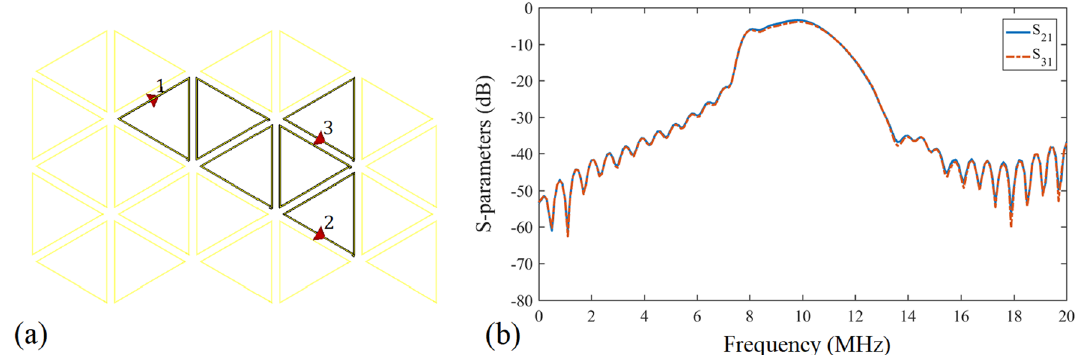
Figure 8. ( a ) A two-receiver power transfer plane model. The highlighted triangles are activated units, and inactive units are in light yellow. ( b ) S 21 and S 31 of the power transfer route in electromagnetic frequency of inactive units f i is 8 MHz in Fig. 7b, shifted by 1.9 MHz compared to activated state. As shown in Fig. 7a, the optimum result of S 21 after coupling through 5 activated units at 9.9 MHz is -0.5 dB, indicating a high